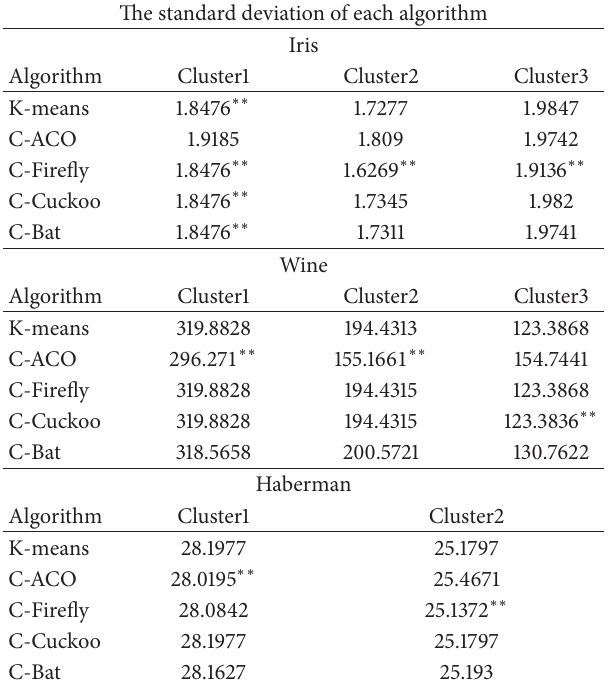
Table 14: Standard deviation measures for different algorithms in different datasets.